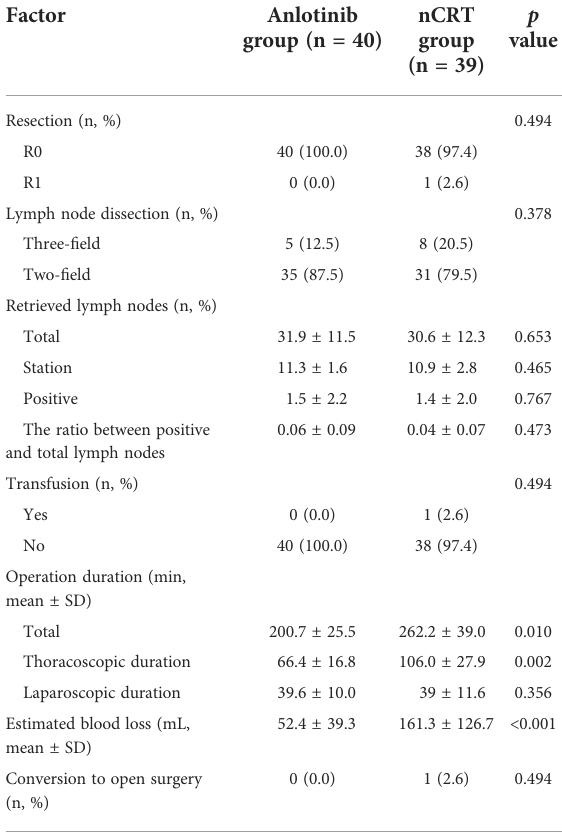
TABLE 2 Surgical outcomes of the two